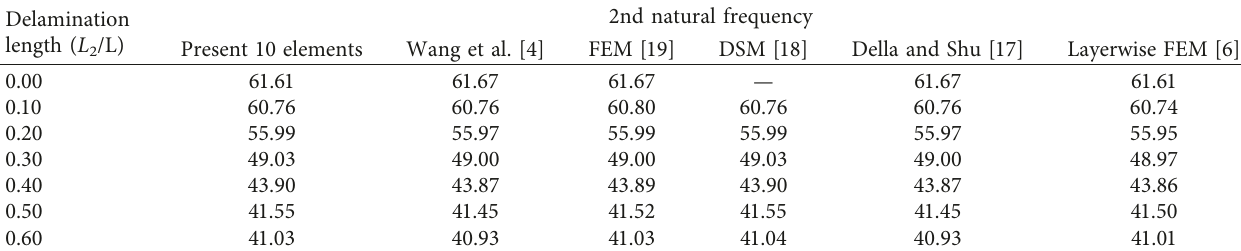
Table 2: The second nondimensional natural frequency ( λ 2 boundary